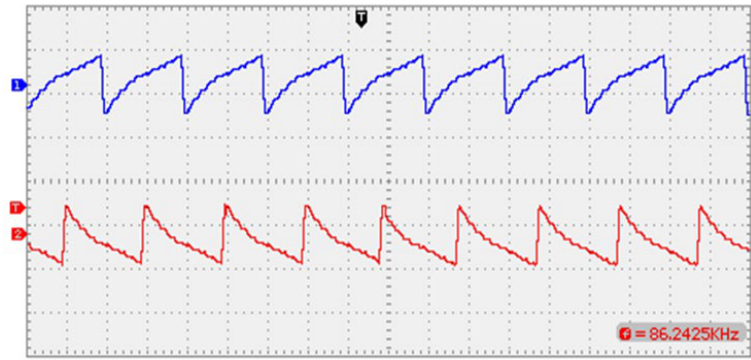
Figure 20. Inductor currents I L 6 ( top ) and I L 5 ( bottom ) (vertical scale 10 A/div). The comparison between the proposed converter and other high step-up TLDCs in terms of voltage gain, voltage stress, soft switching, switching frequency, and the number of active elements is presented in Table 2. Table 2. A comprehensive comparison between the proposed converter and other TLDCs. Ref.